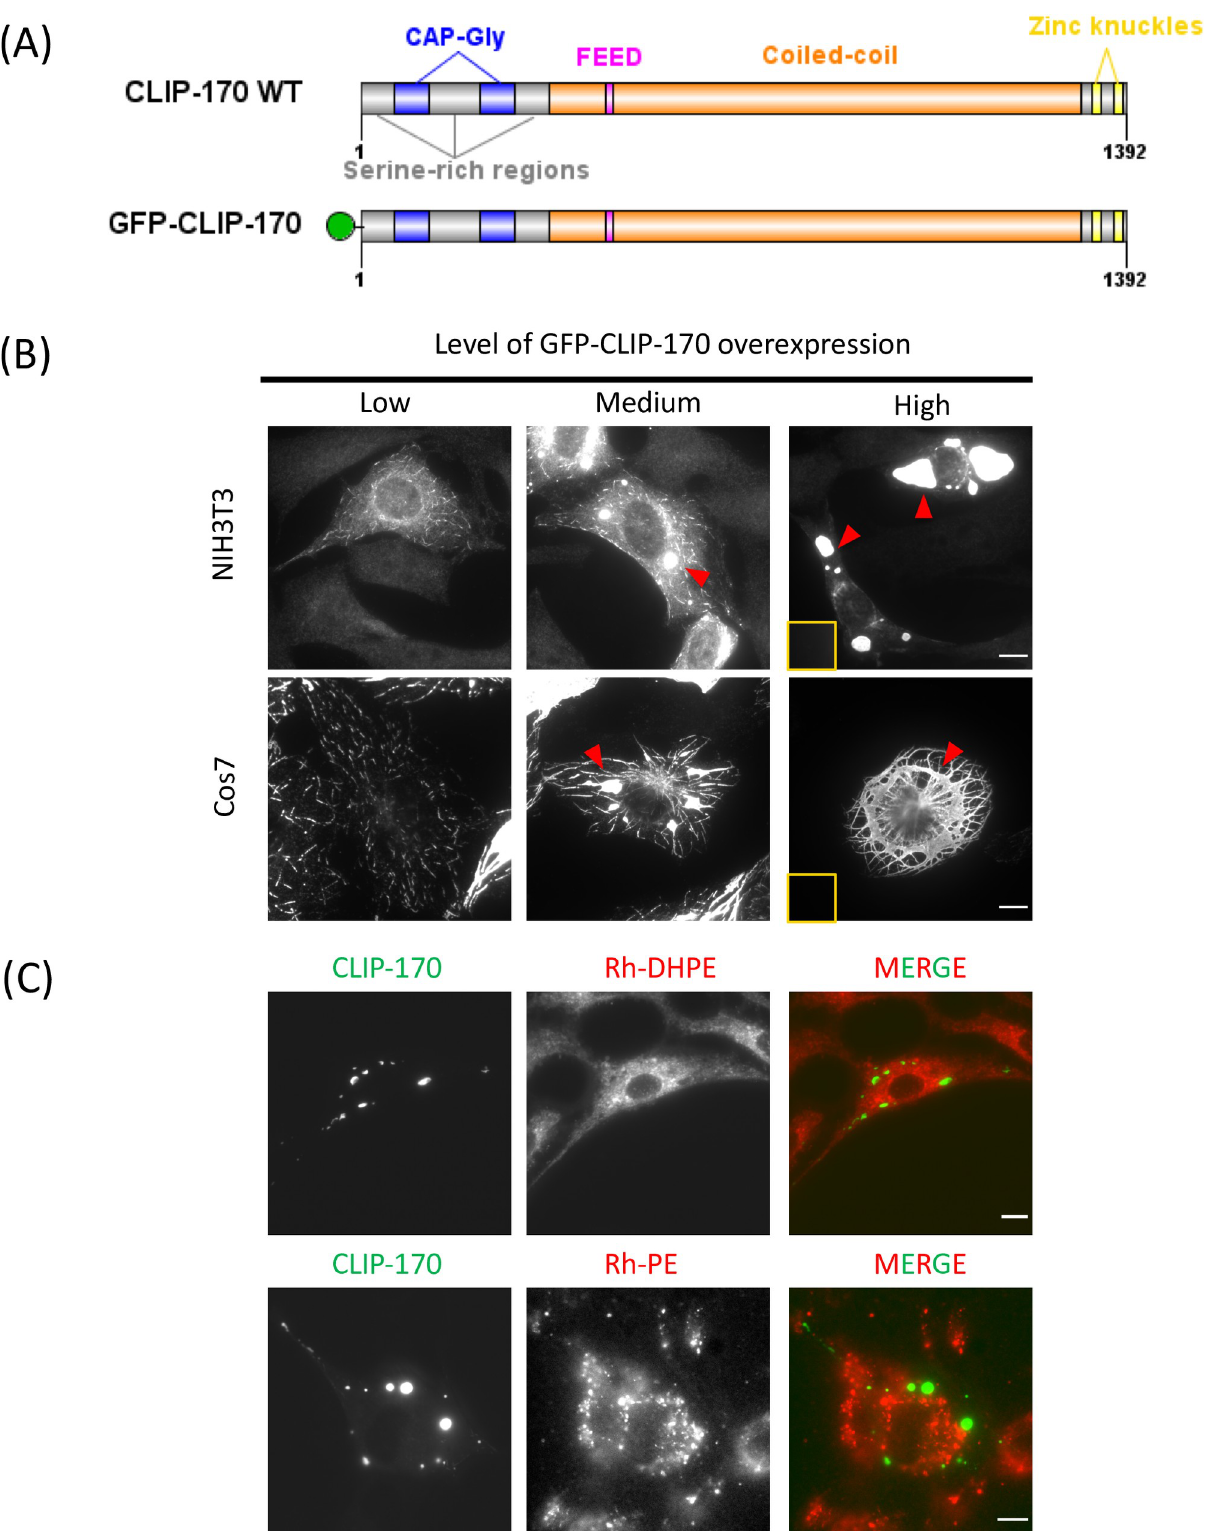
Fig 2. CLIP-170 patches do not colocalize with membrane markers. (A) Domain structures of the CLIP-170 constructs used in this study. (B) NIH3T3 or Cos-7 cells (as indicated) were transfected for 24 hr to overexpress GFP-CLIP-170, fixed with PFA, and observed by widefield fluorescence